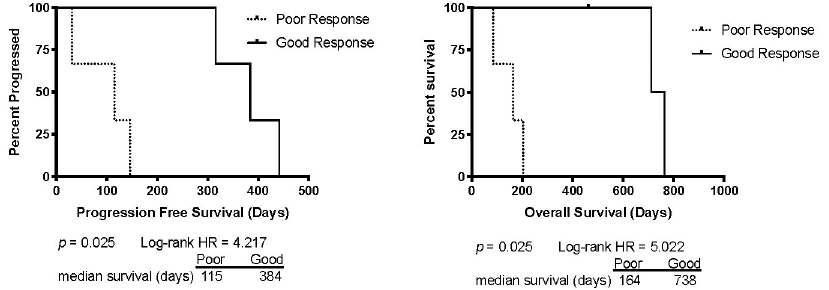
Fig 1. Kaplan Meier curves for Progression Free Survival (PFS) and Overall Survival (OS) for the ‘poor’ and ‘good’ outcome groups. The ‘poor’ outcome group consisted of cases with PFS � 231 days and the ‘good’ outcome group consisted of cases with PFS > 231 days. The one upward tick on the OS curve represents one dog that was still alive when the data were collected, so the time at last follow-up was censored. Log-rank analysis showed that there were significant differences in PFS and OS between